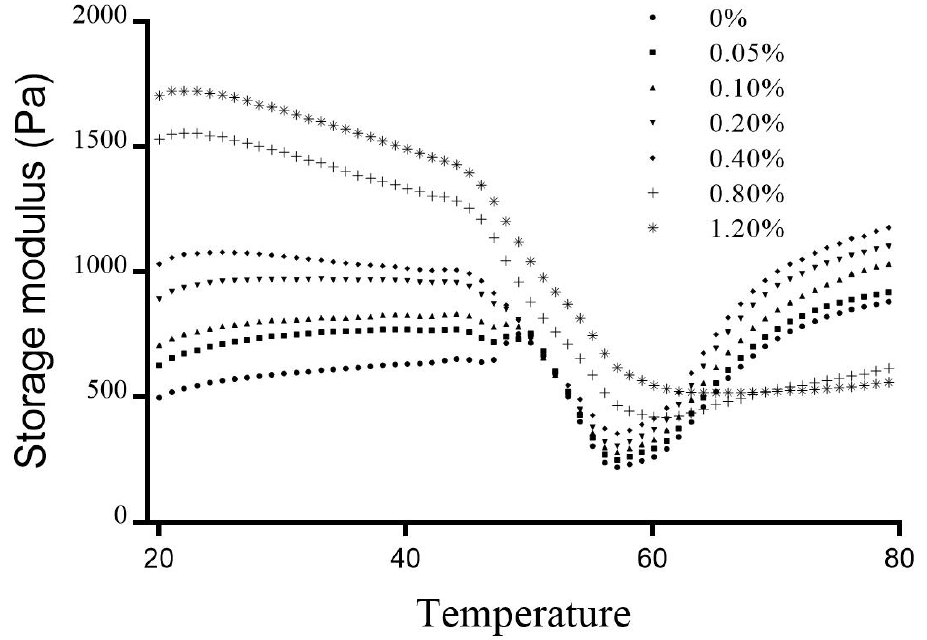
Figure 1. Storage modulus (G (cid:48) ) of the composite gels with various CG addition. 0%: the control; 0.05%: MP with 0.05% CG; 0.10%: MP with 0.1% CG; 0.20%: MP with 0.2% CG; 0.40%: MP with 0.4% CG; 0.80%: MP with 0.8% CG; 1.20%: MP with 1.2%